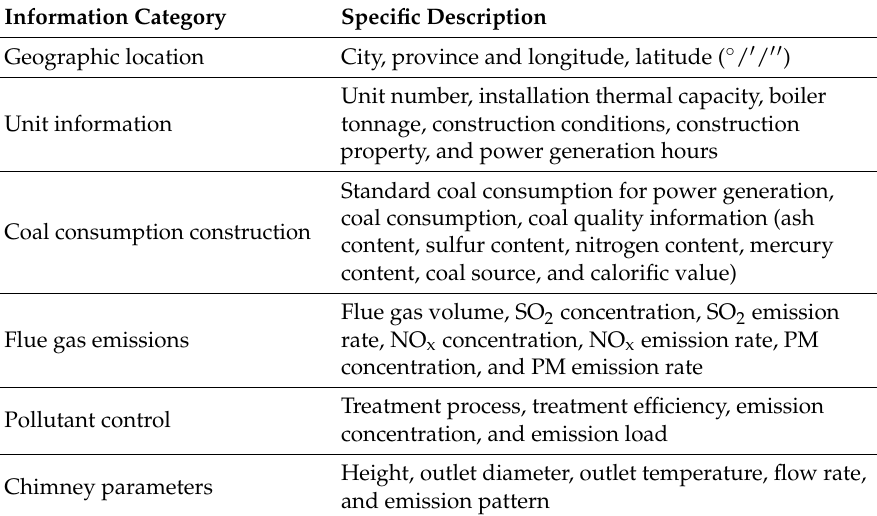
Table 1. Information gathering